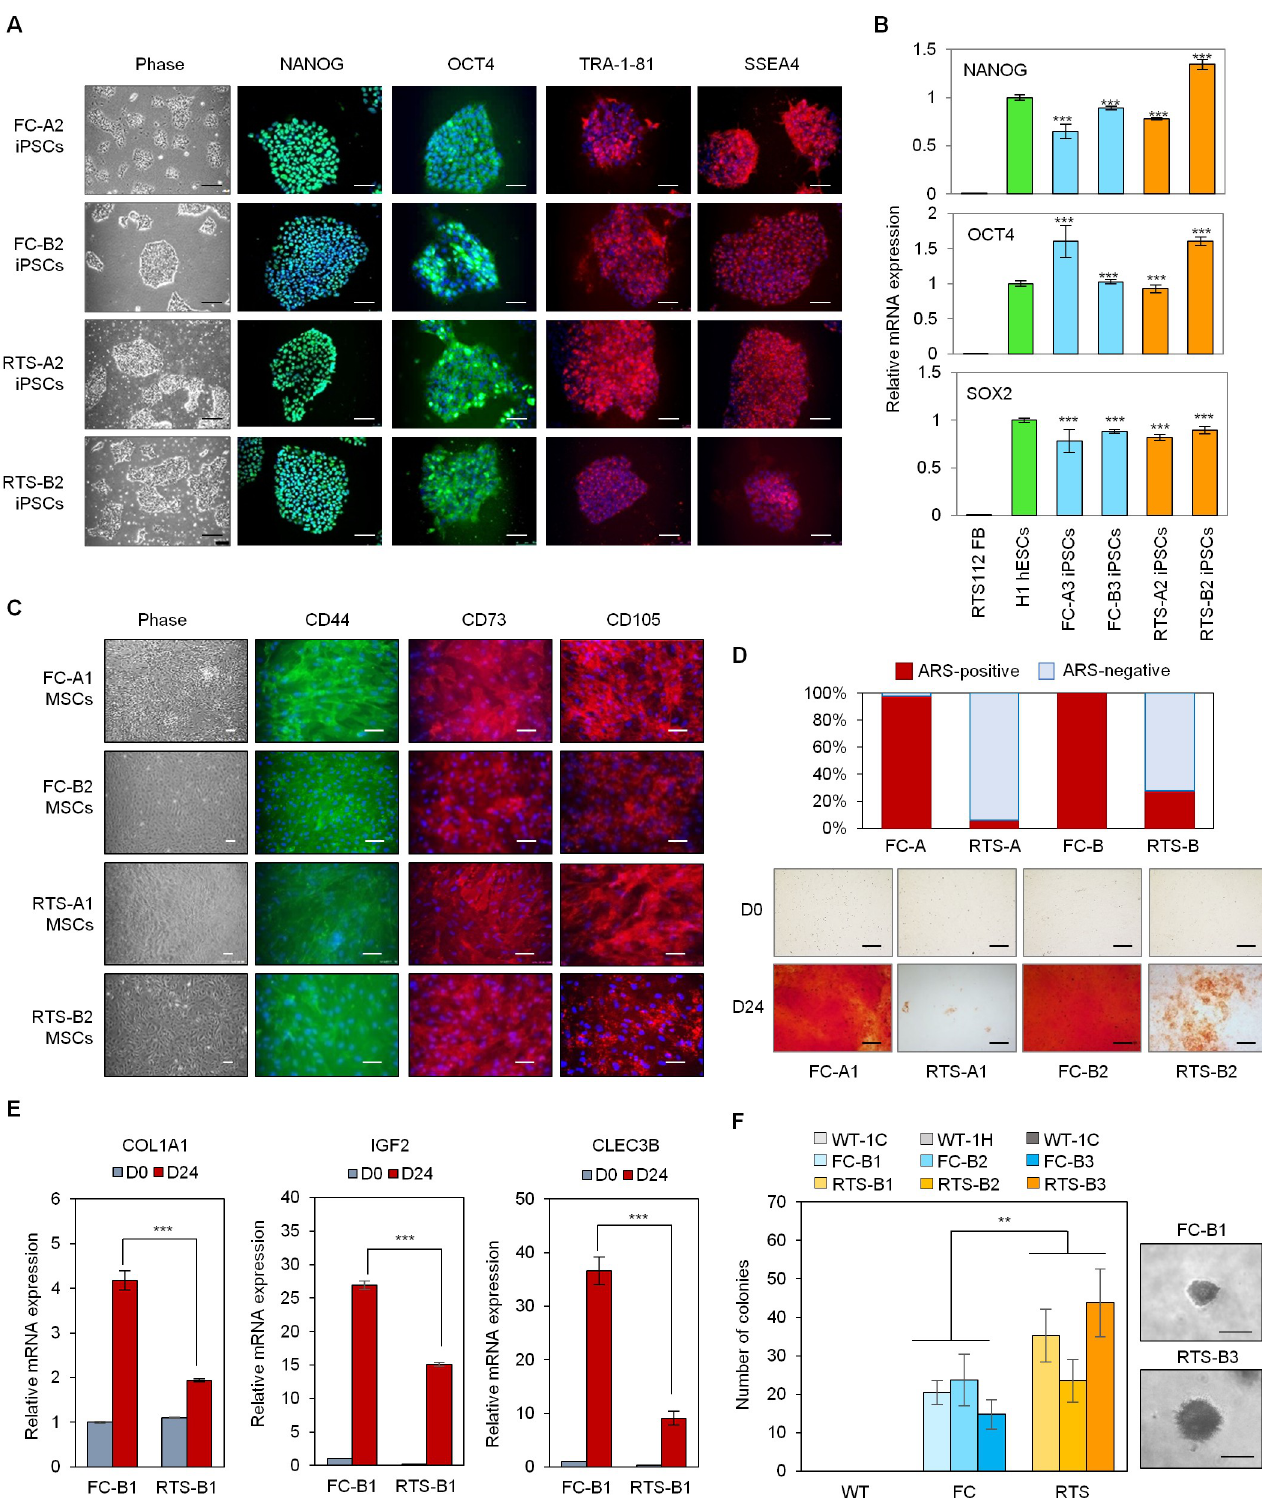
Fig 2. Generation of RTS iPSCs and iPSC-derived osteoblasts. (A) RTS and FC iPSCs exhibit hESC morphology and express pluripotency transcription factors NANOG and OCT4 as well as hESC surface antigens TRA-1-81 and SSEA44 ubiquitously. Scale bar, 100 μ m. (B) qRT-PCR assay for pluripotency genes NANOG , OCT4 , and SOX2 in RTS and FC iPSCs. Error bars indicate SEM of triplicates. n = 3 biological replicates. (C) Immunostaining demonstrates